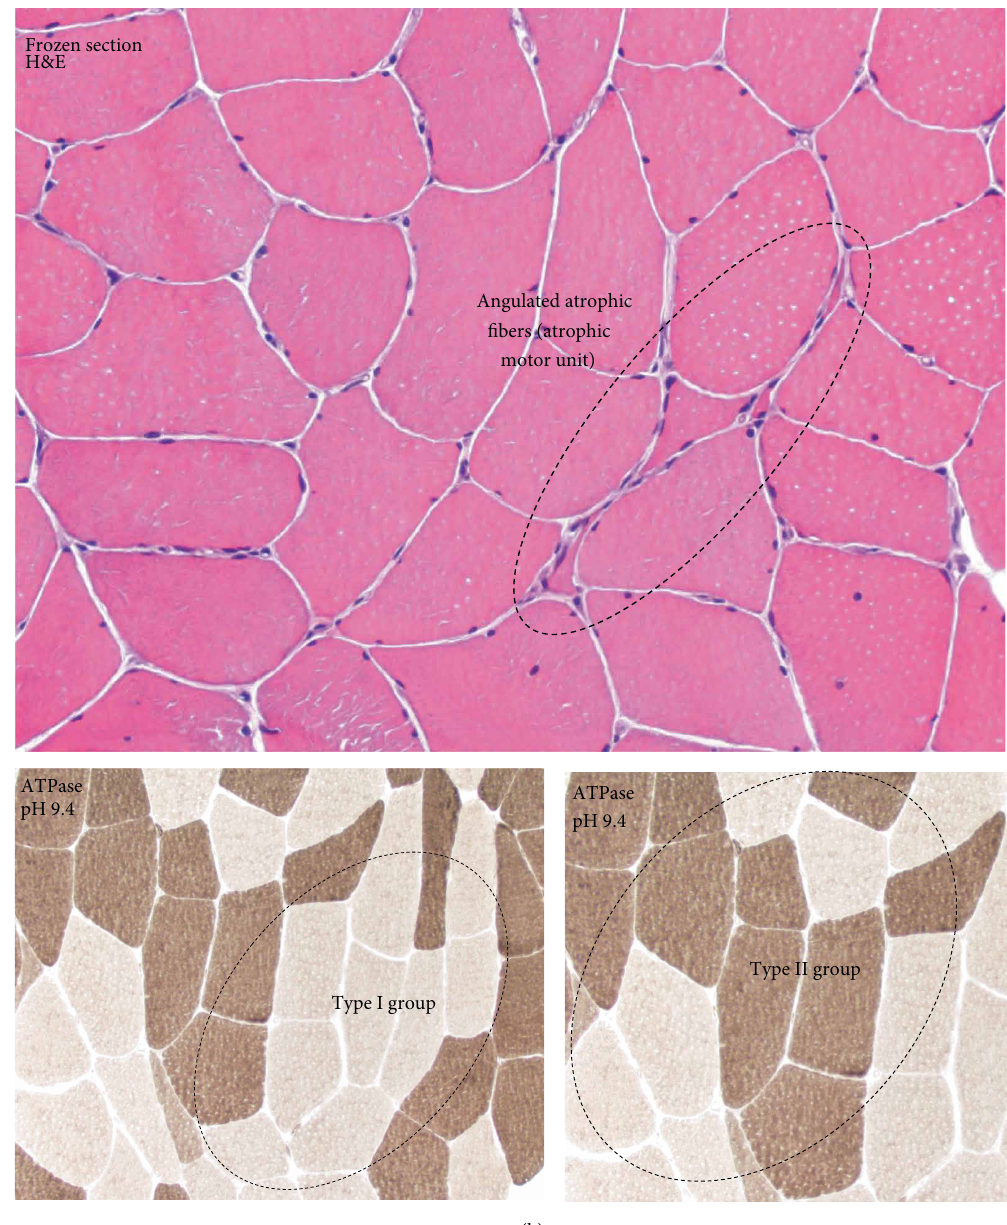
Figure 2: Muscle biopsy of the left